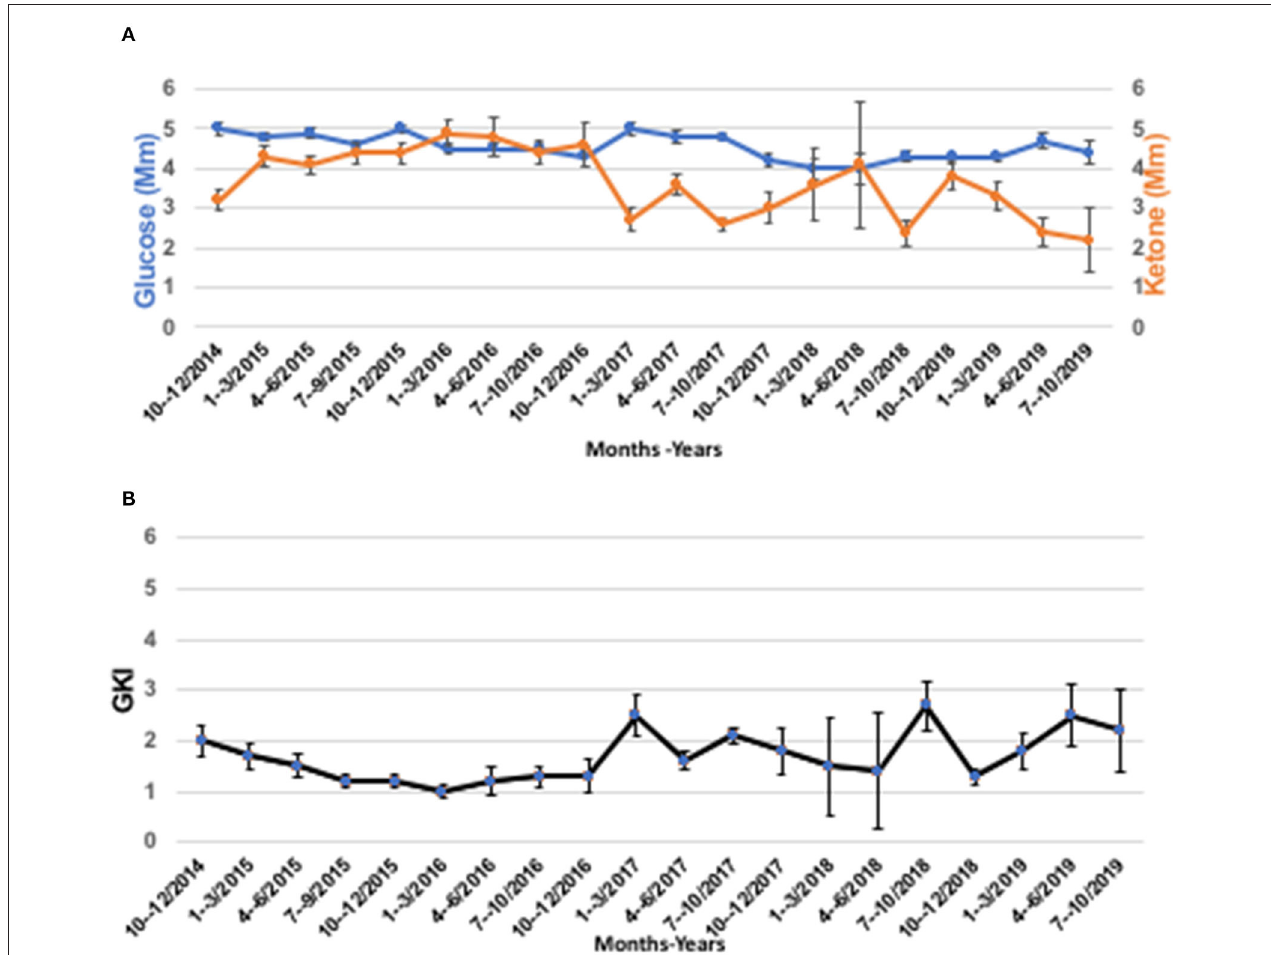
FIGURE 3 | The patient’s blood glucose, ketone, and GKI values from 2014 to 2019. (A) Blood glucose, and ketone ( β -OHB) values determined using Precision Xtra blood glucose & ketone meter as described in text. (B) GKI values were determined from the individual glucose and ketone values in A using the glucose ketone index calculator, as previously described (77). Individual values were pooled over 3-month time intervals and are expressed as means ± 95% confidence intervals (CI). The number of readings for each data point in A and B ranged from a high of n = 151 (July-September, 2017), to a low of n = 7 (April-June 2018), and are given in the Supplementary Tables 1A–F arranged by year from 2014 to